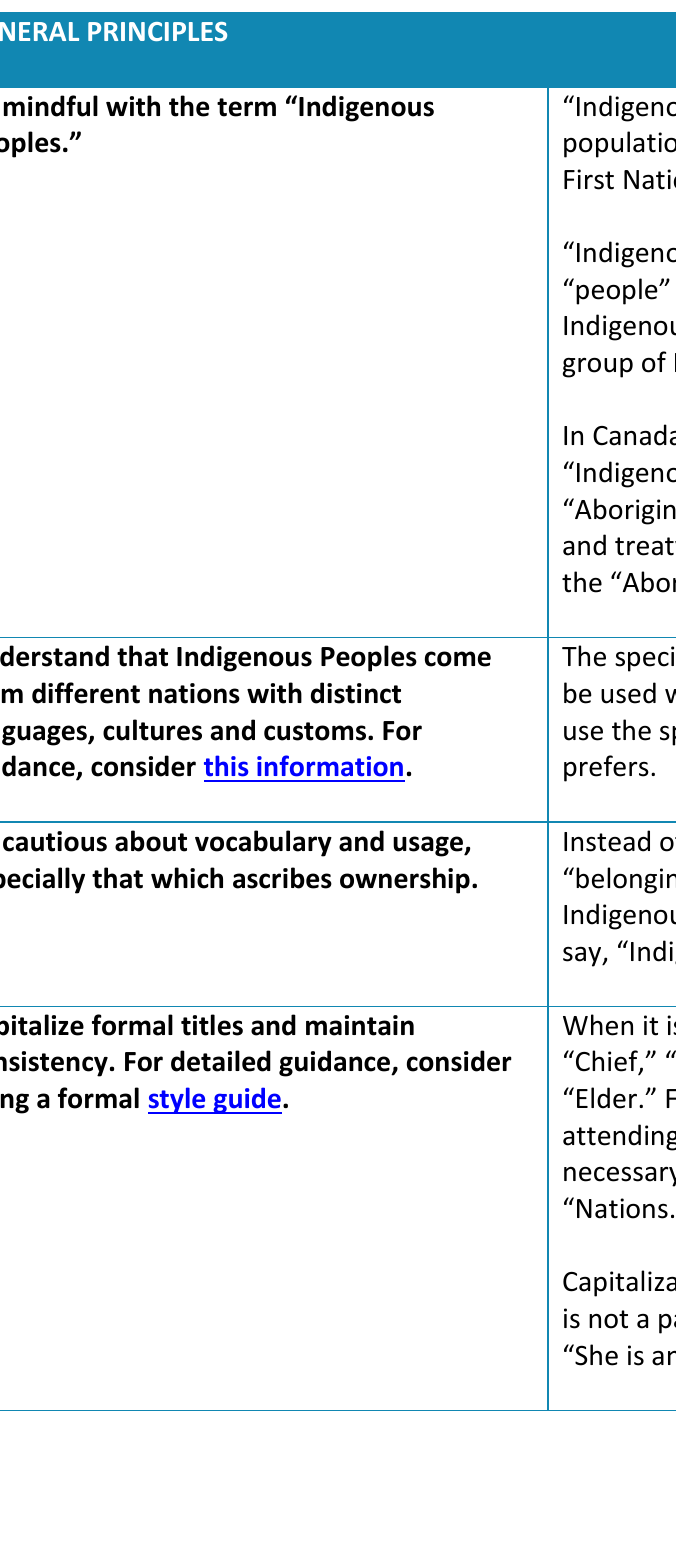
Page | 13 | Words Matter: Guidelines on Using Inclusive Language in the